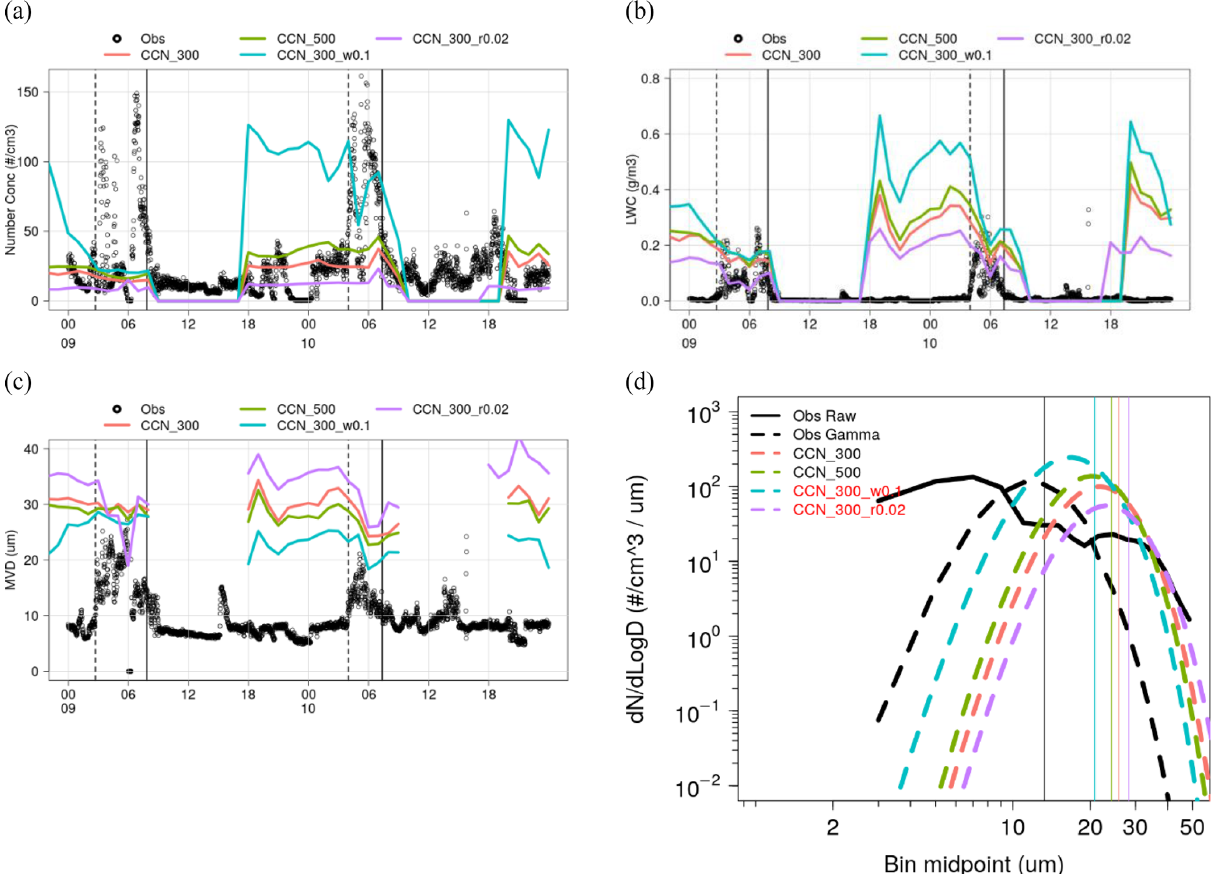
Figure 20. Observed and modelled DSD for (a) case 1 and (b) case 2. Black solid lines are the observed distributions. Black dashed lines are the equivalent theoretical gamma distribution applied to the observed data. Other dashed lines are model distributions. Vertical solid lines represent the MVD. Time is in UTC (site is UTC +